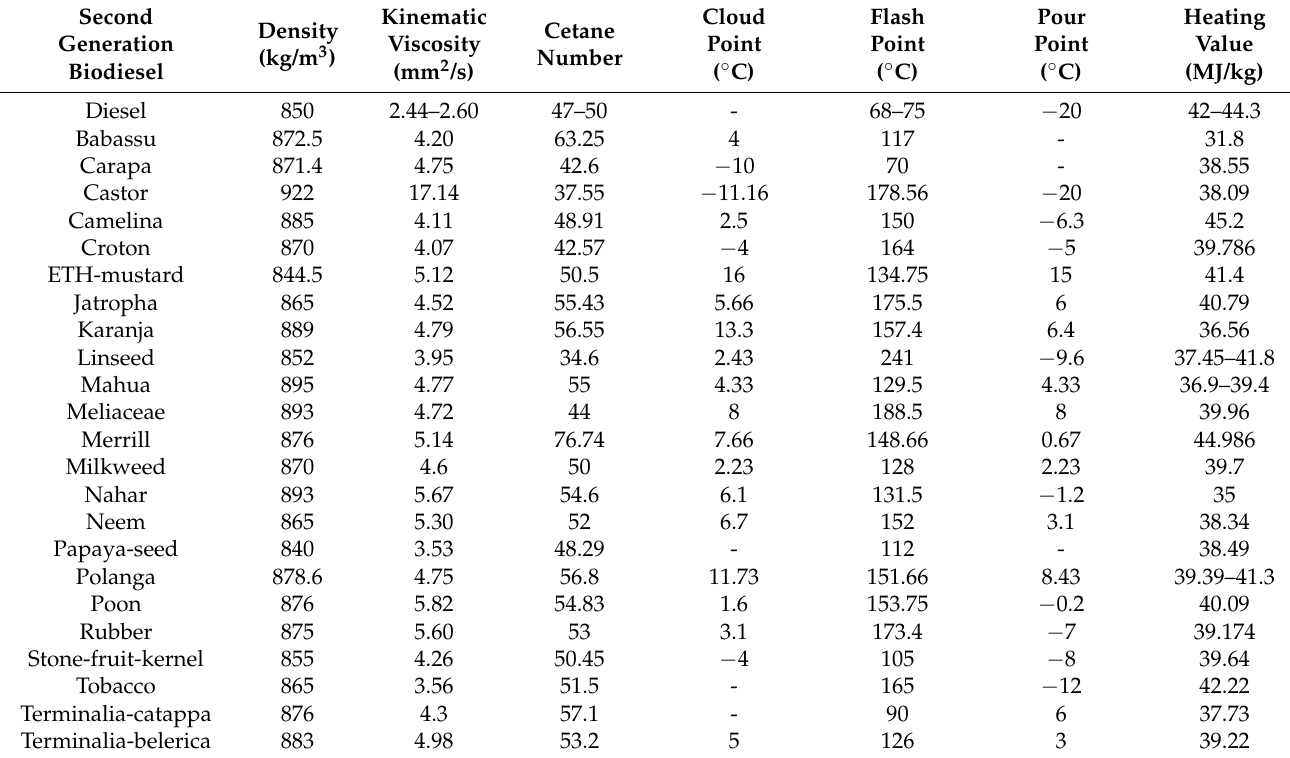
Table 5. Properties of second ‐ generation biodiesel [90,121,127–131].